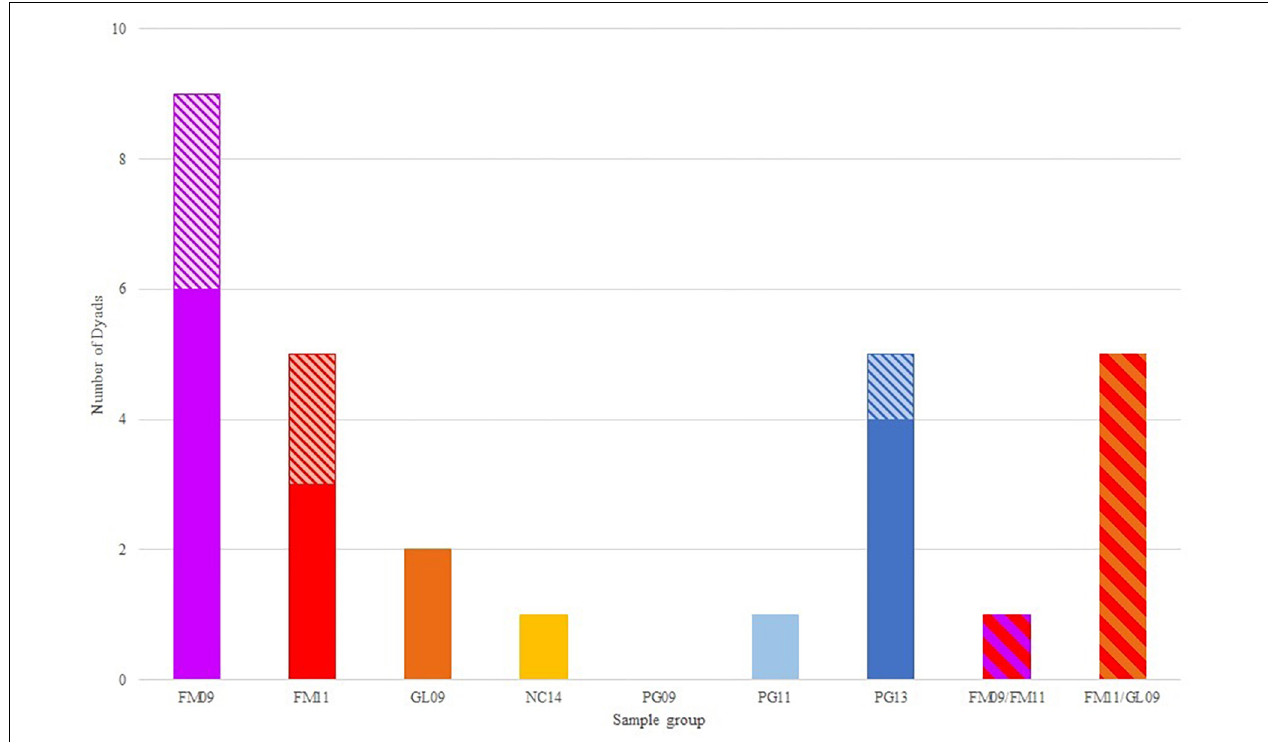
FIGURE 4 | Number of full sibling dyads identified in each sample group, and between groups. Solid bars represent dyads from the same catch event, horizontally striped bars represent those from different catch events.